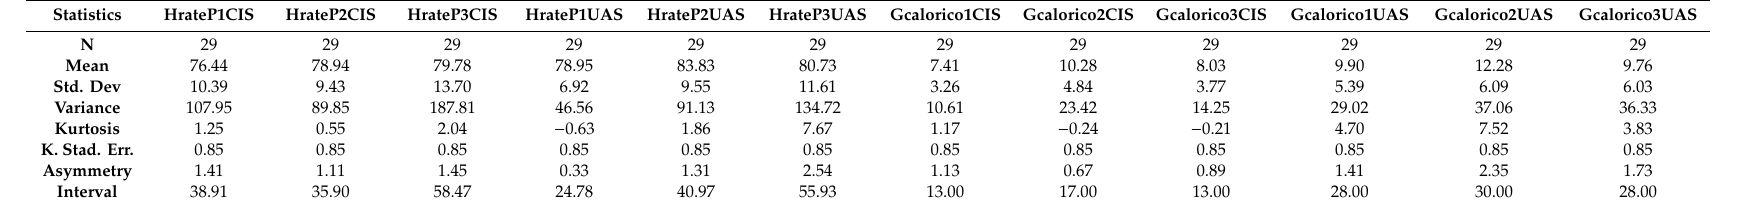
Table 3. Descriptive analysis of HR and caloric expenditure variables for field